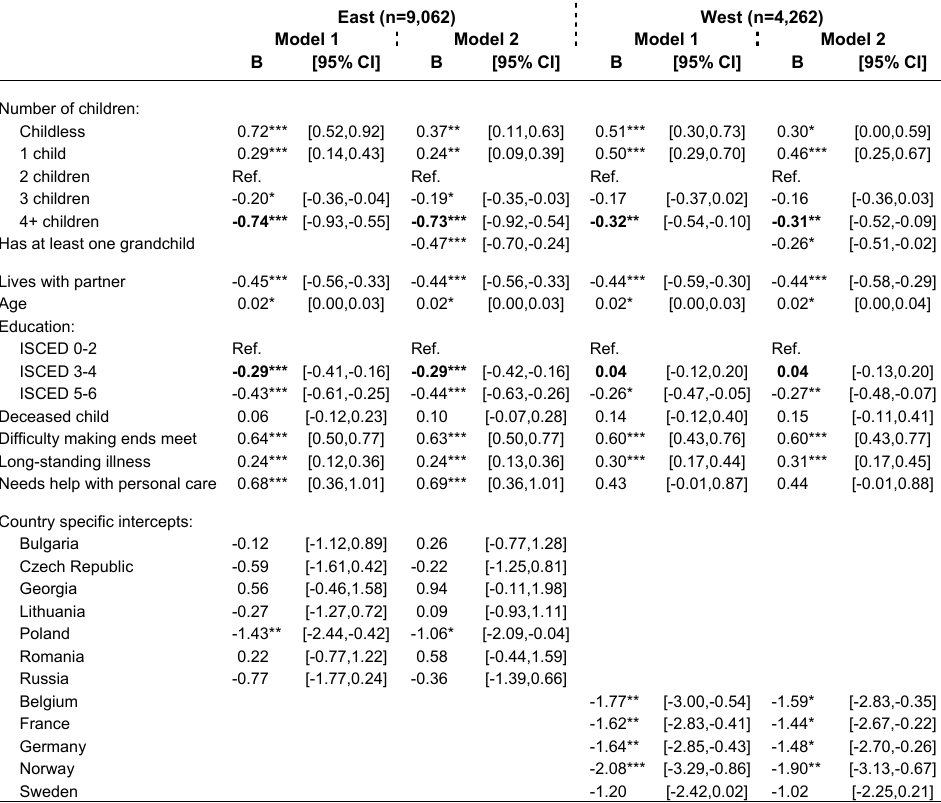
Table 2 : Coefficient estimates from logistic regression models for loneliness among